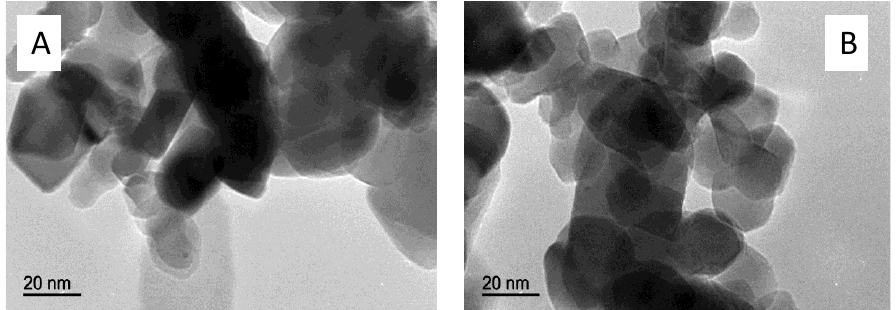
Figure 5. TEM micrographs of Ni-0.5-DP solid after the reaction under UV ( A ) or solar ( B ) irradiation.